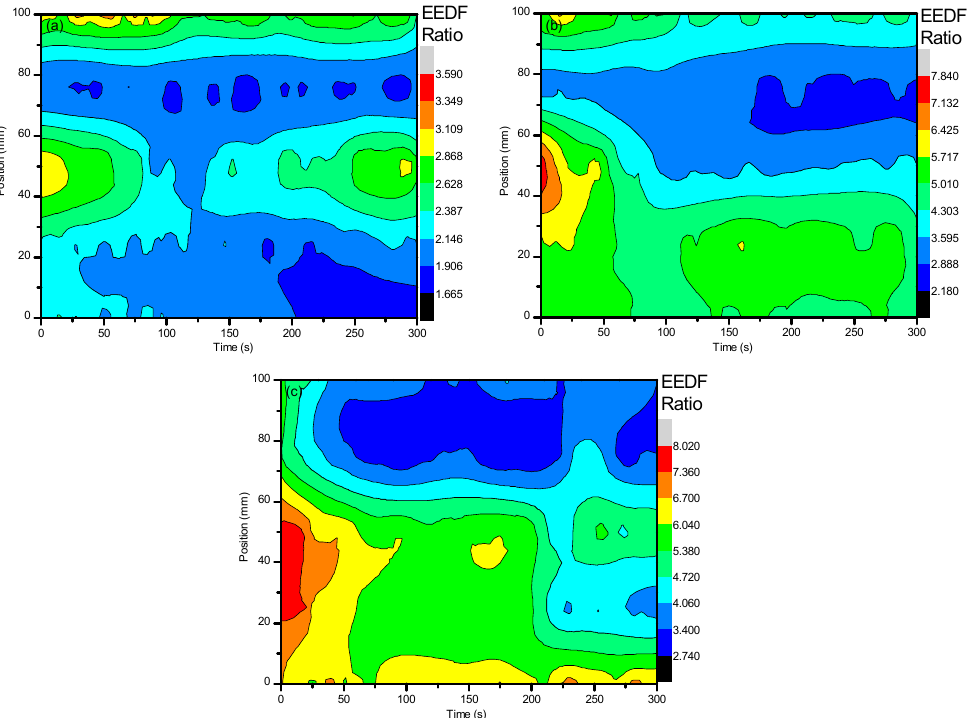
Figure 3. The line ratio of (N 2 -337/N 2+ -391) to give the EEDF when using ambient air. This portrays how the electron energies were altered with the different parameter settings, most importantly the variation of working gas composition. ( a – c ) represent discharge at 27, 29.6, and 32 kV, respectively. With an addition of CO 2 at ≈ 3.8% to the system, a drastic change in the electron energies was incurred. By using the same line ratio method and spectral line profiles (N 2 -337/N 2+ -391) that